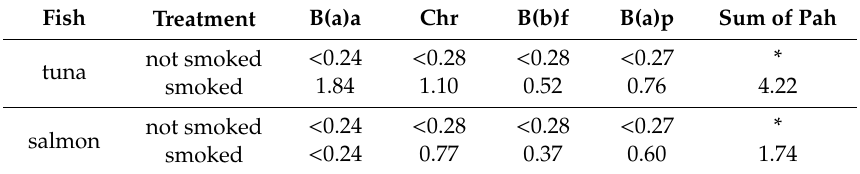
Table 6. The content of polycyclic aromatic hydrocarbons (PAH) in µ g · kg − 1. Fish Treatment B(a)a Chr B(b)f B(a)p Sum of Pah not smoked < 0.24 < tuna